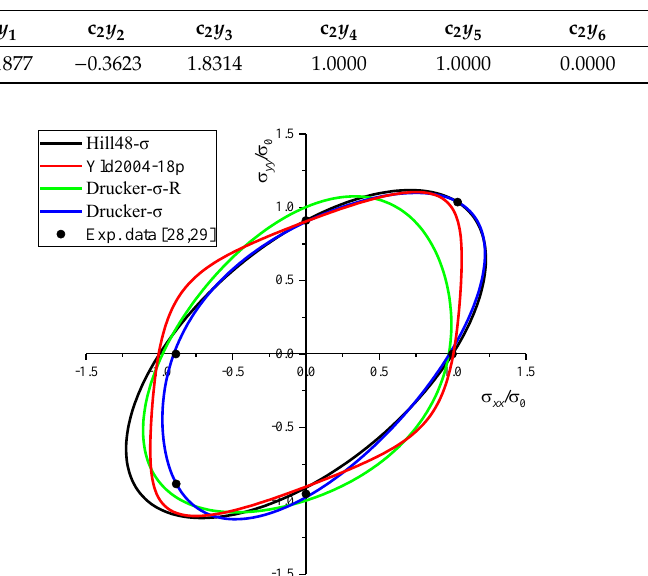
Figure 1. Yield surfaces with four yield functions for AA 2090-T3 sheet. Ducker- σ -R is determined by Equation (40), while Ducker- σ is determined by Equation (41). The biaxial compressive stress shown here is obtained by ( σ c 0 + 2 σ c 45 + σ c 90 )